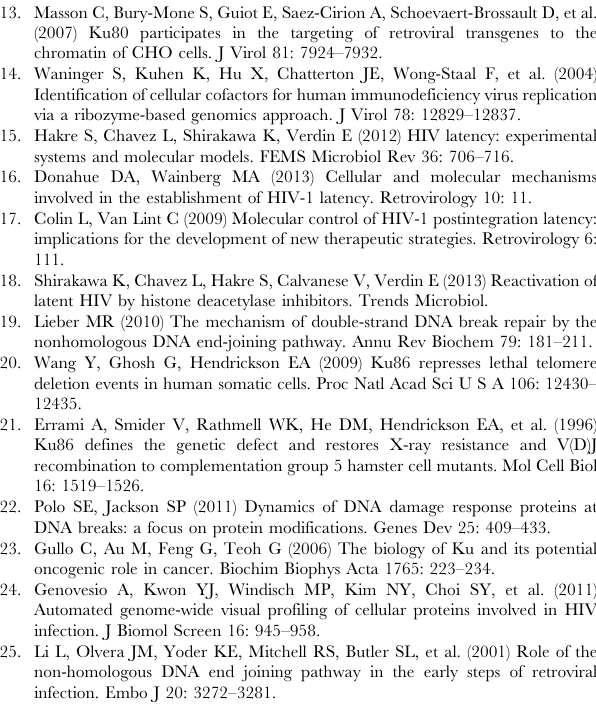
Table S1 HERV groups analyzed by RT-Q-PCR. Table S2 Sequence of primers, probes and siRNA used for this